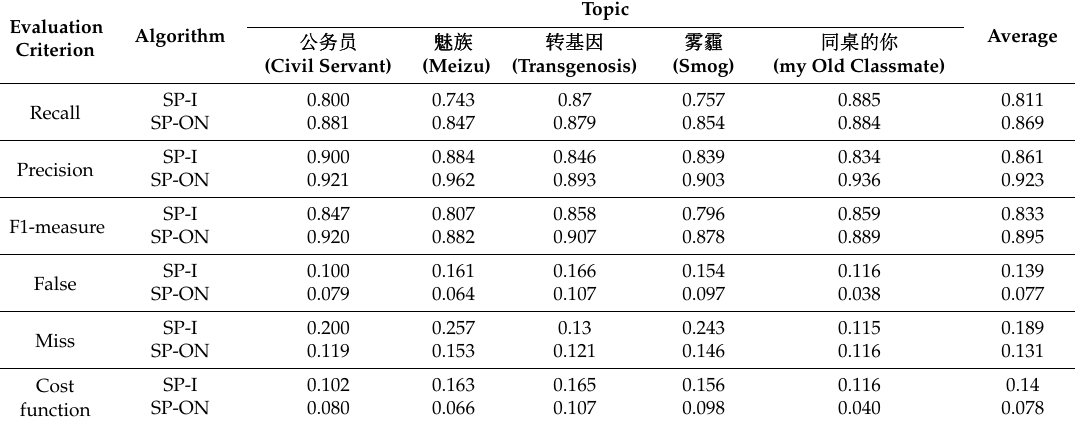
Table 4. Topic tracking result when the similarity threshold is